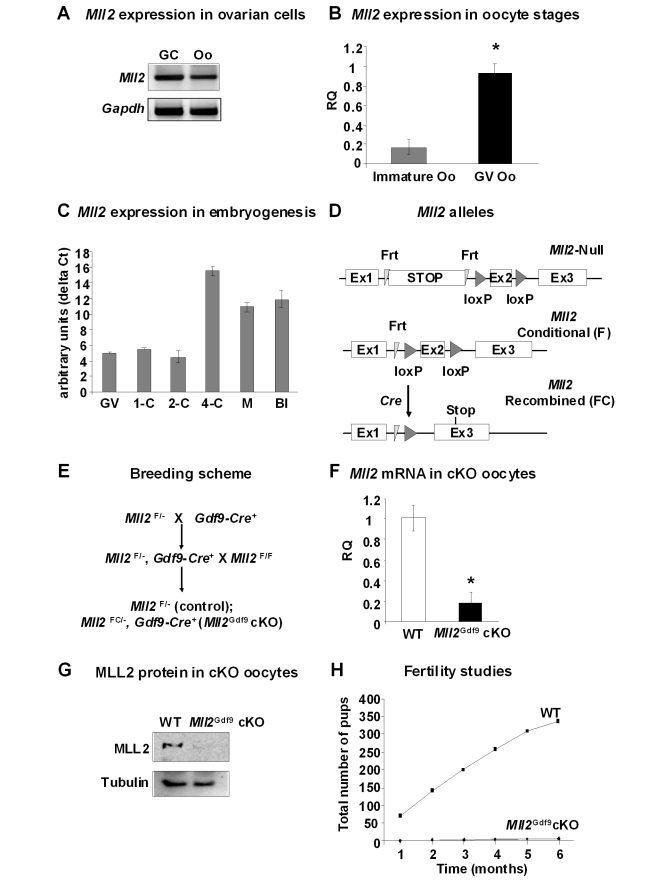

Mll2 oocyte-specific deletion mediated by the Gdf9-Cre allele leads to female infertility and premature follicle loss.(A) RT-PCR analysis of Mll2 showed expression in ovarian granulosa cells (GC) and peri-ovulatory (GV) oocytes (Oo) as determined. (B) Real time PCR (QPCR) analysis of meiotically incompetent (immature) oocytes from 12-d-old females and mature peri-ovulatory (GV, germinal vesicle) oocytes showed a significant increase in Mll2 mRNA levels towards the peri-ovulatory stage (Student's t test, * p<0.05; three pools of oocytes were used in the analysis; n = 3). Results are shown relative to Mll2 levels in GV oocytes (RQ). Gapdh was used as endogenous control. (C) QPCR analysis of preimplantation embryos revealed that Mll2 is present in 1-cell embryos, likely as a maternal product, and also in subsequent embryonic stages up to the blastocyst (Bl) stage. Gapdh was used as endogenous control. Results are shown as arbitrary units (delta CT: CT values corrected by the endogenous control). Abbreviations: GV, germinal vesicle oocytes; 1-C, 1 cell embryos; 2-C, 2 cell embryos; 4-C, 4 cell embryos; M, morula; Bl, blatocyst. (D) cKO mice were generated by tissue-specific deletion of the Mll2 floxed (“F”) allele in the Mll2 null allele background. The “F” allele was generated after FLP recombination to remove the stop cassette. Cre recombination eliminates the second exon, thereby causing a frame-shift (“FC” allele). (E) Breeding scheme used to generate Mll2Gdf9 cKO mice. (F) Mll2Gdf9 cKO oocytes show a significant reduction in Mll2 mRNA levels (Student's t test, * p<0.05). Results are shown as means ± S.E. relative to WT (RQ) (three oocyte pools were used; n = 3), and Gapdh was used as endogenous control. (G) Mll2Gdf9 cKO oocytes show negligible levels of MLL2 protein as assessed by Western blot analysis; tubulin was used as loading control. (H) Mll2Gdf9 cKO females were infertile; the cumulative number of pups over a 6-mo period is shown (n = 10).